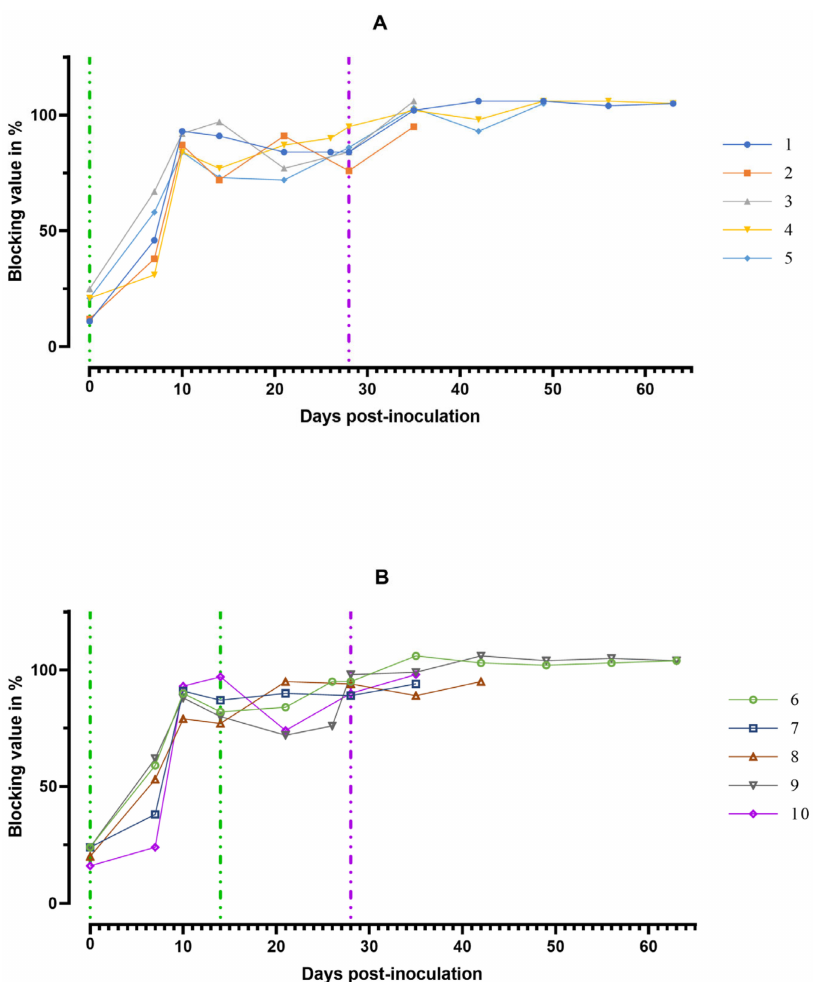
Figure 6. Individual kinetics of antibodies to ASFV in blood serum samples: ( A ) group #1 after inoculation with the ASFV-Katanga-350 and challenge on the 28th day with the ASFV-Stavropol 01/08; ( B ) group #2 after two inoculations with the ASFV-Katanga-350 and challenge on the 28th day with the ASFV-Stavropol 01/08. Each curve represents the values of individual animals. Vertical dashed lines: green—days of inoculation of ASFV-Katanga-350, purple—challenge by the ASFV– Stavropol